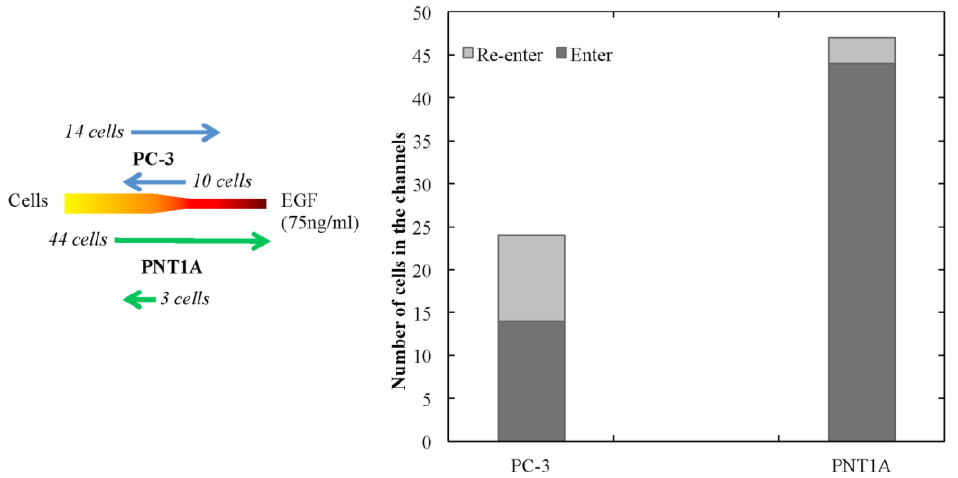
Figure 3. The comparison of the migration patterns between PC-3 and PNT1A cells when cells were seeded on the wider end of the tapered channels. The arrows and numbers indicate the direction of cell migration and the number of cells under migration. PC-3 re-entry is at a much higher rate than that for